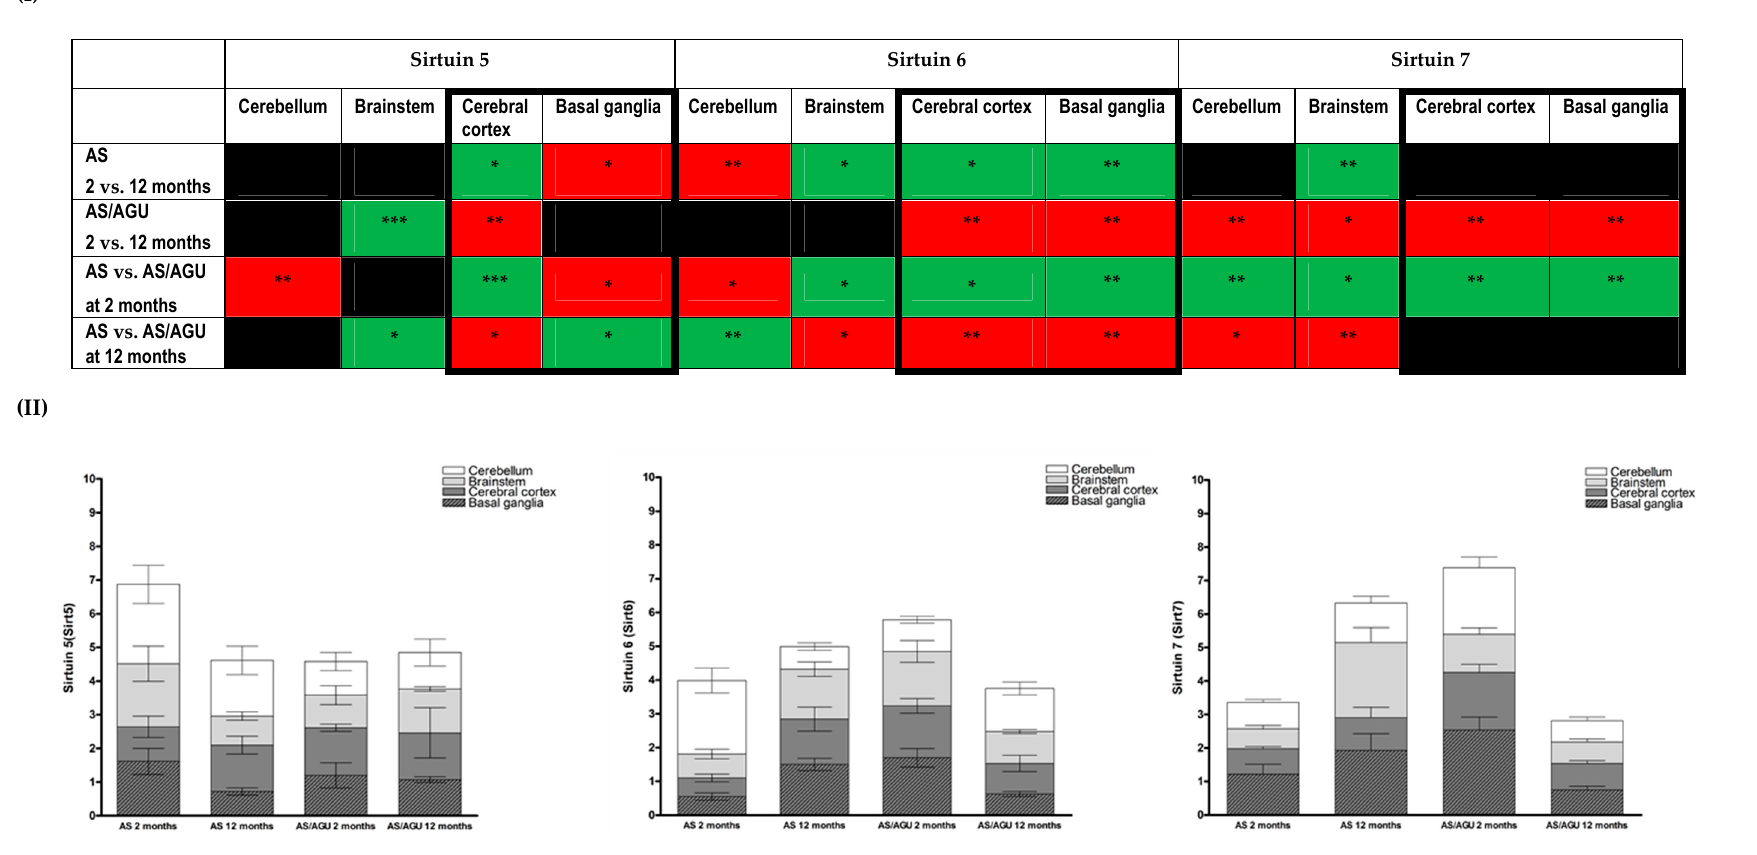
Figure 3. (I) A summary of Sirt5, Sirt6, and Sirt7 gene expression measured using qPCR across brain regions in AS and AS/AGU strains at two and 12 months. Green colour denotes an increase, while red denotes a decrease in relative gene expression. Significance: * p < 0.05, ** p < 0.01, *** p < 0.001. Black colour denotes the lack of significant changes in the gene expression. Regions of the brain linked to the Parkinson’s disease are bolded for easier comparison. (II) Stacked bar charts represent mean RQ sirtuin values with SEM for each individual brain region in both rat strains at the two time points. Each bar represents the mean with SEM for an individual category.